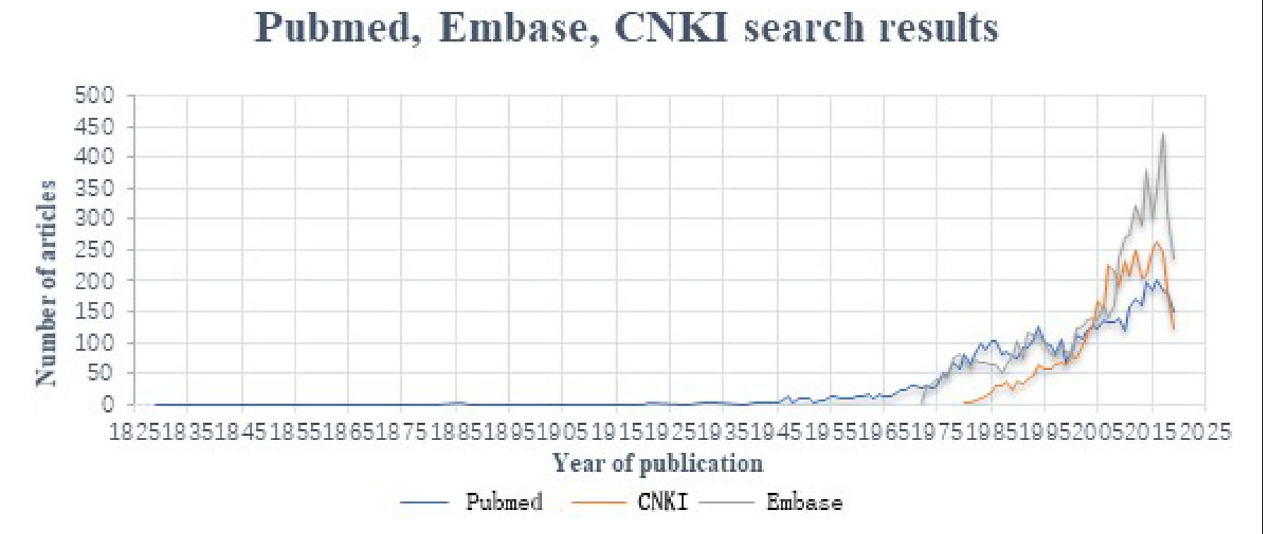
FIGURE 3 | The number of documents in each database changes with